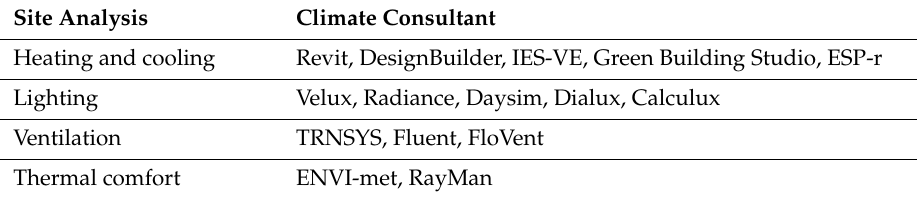
Table 1. Common simulation tools taught in design schools in the UK.